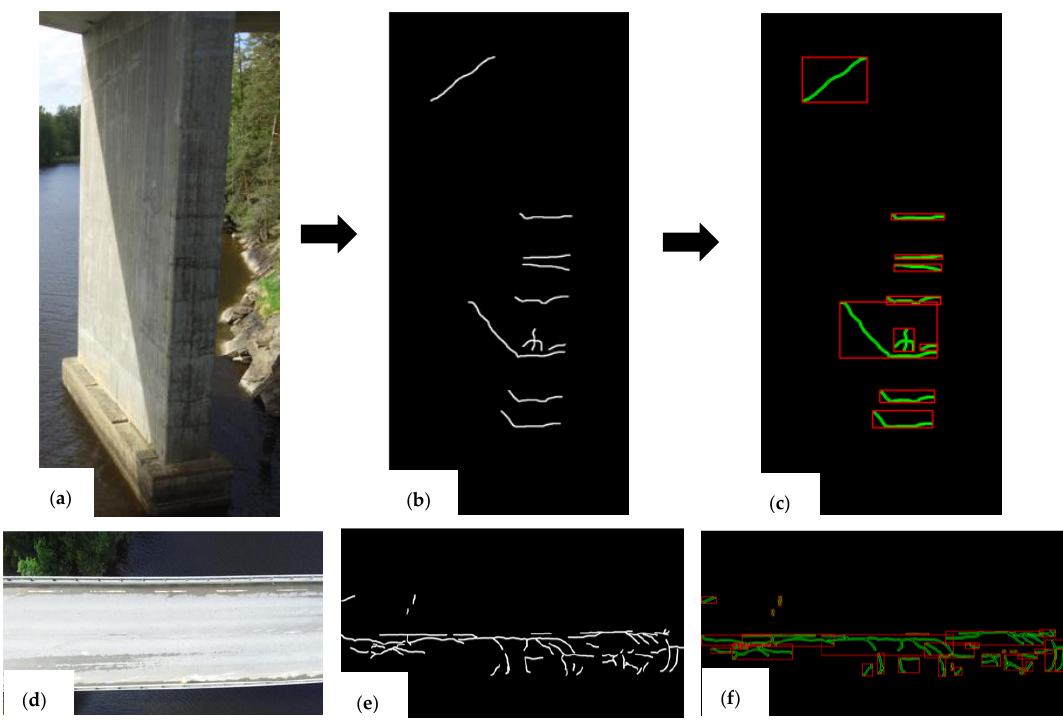
Figure 6. ( a ) drone image of Skodsberg bridge supporting, ( b ) tracing of contours, ( c ) extracting bounding box, ( d ) drone image of Skodsberg bridge deck, ( e ) bridge deck tracing of contours, ( f ) bridge deck extracting bounding box.